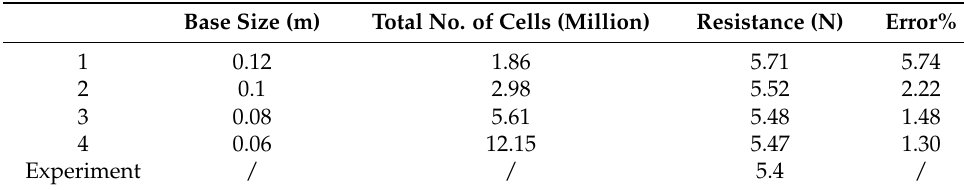
Figure 8. An illustration of grid arrangement. Table 5. Mesh sensitivity analysis of